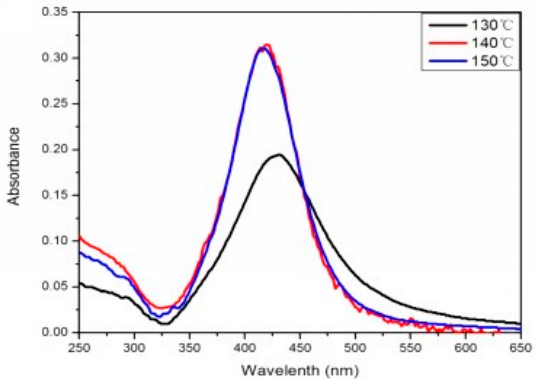
Figure 2. UV–vis extinction spectra of the products prepared at different temperatures at PEG:EG ratio of 1:2.